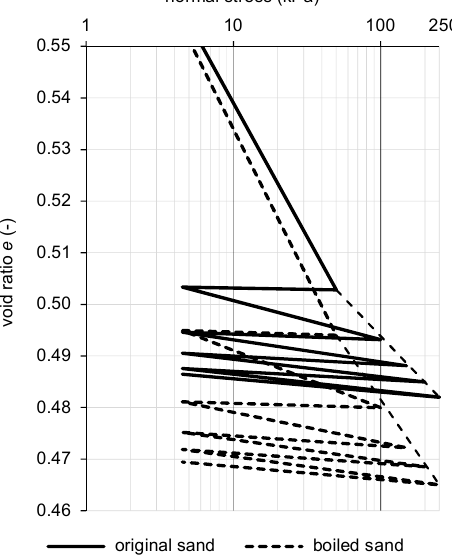
Figure 15. Normal stress-void ratio relation for kinetic sand (semi-logarithmic scale).